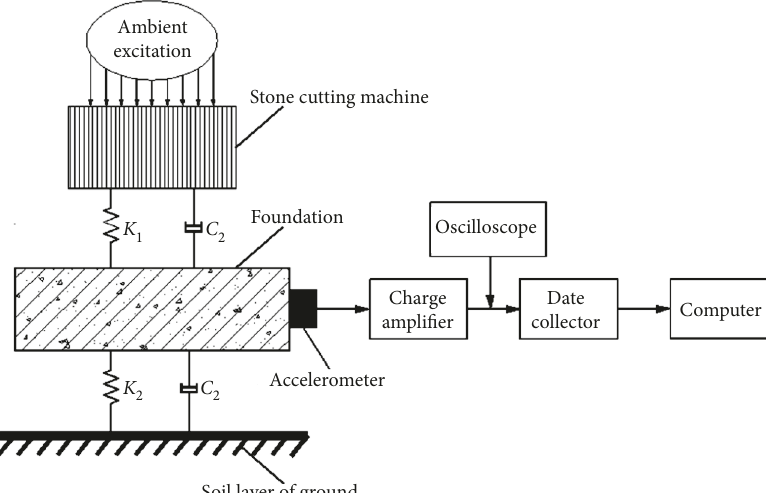
Figure 3: Flowchart for modal test of foundation of stone cutting